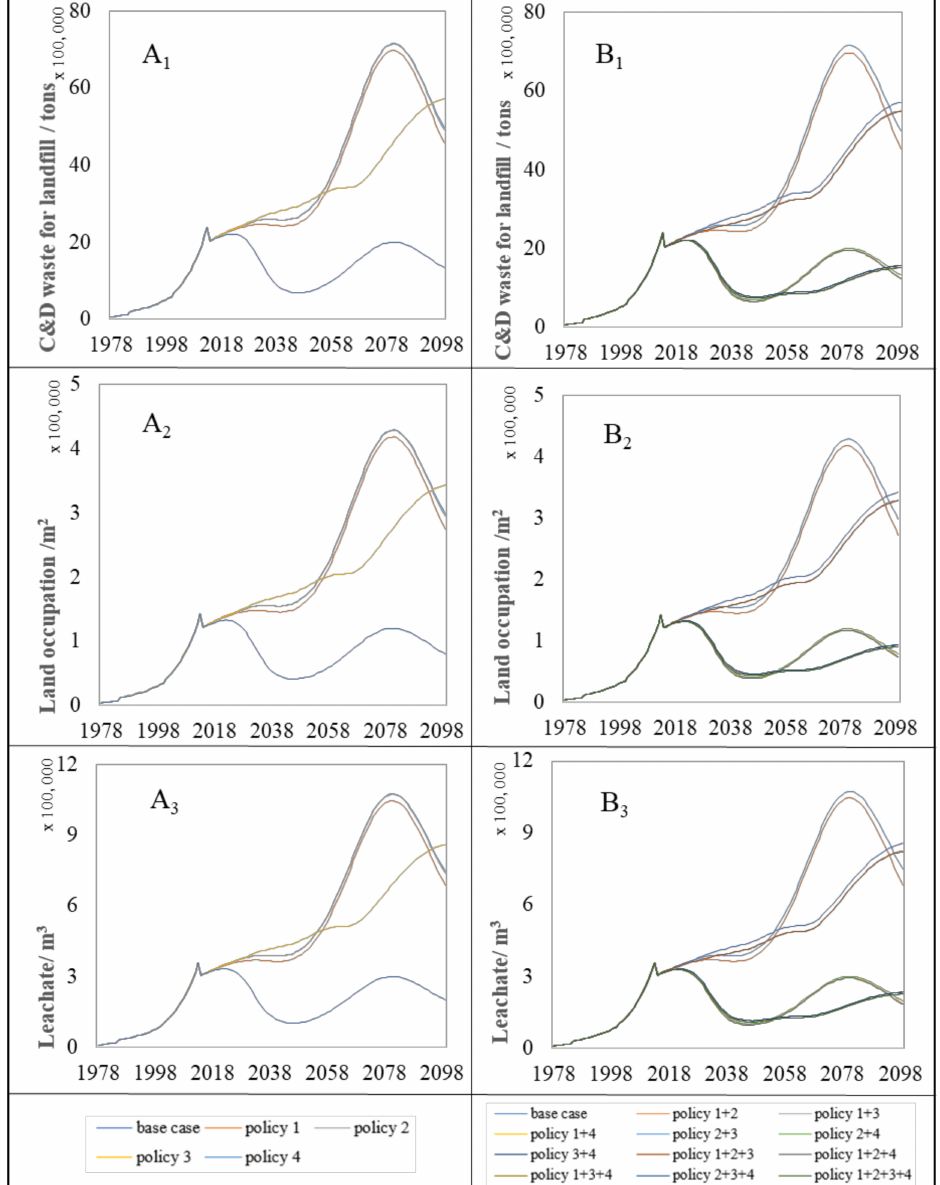
Figure 4. Annual environmental impacts trends for proposed policy measures. A 1 and B 1 represent the impact trend of single policy and complex policy on C&D waste for landfill, respectively. A 2 and B 2 are the impact trend of single policy and complex policy on land occupation, respectively.A 3 and B 3 indicate the impact trend of leachate under single policy and complex policy,